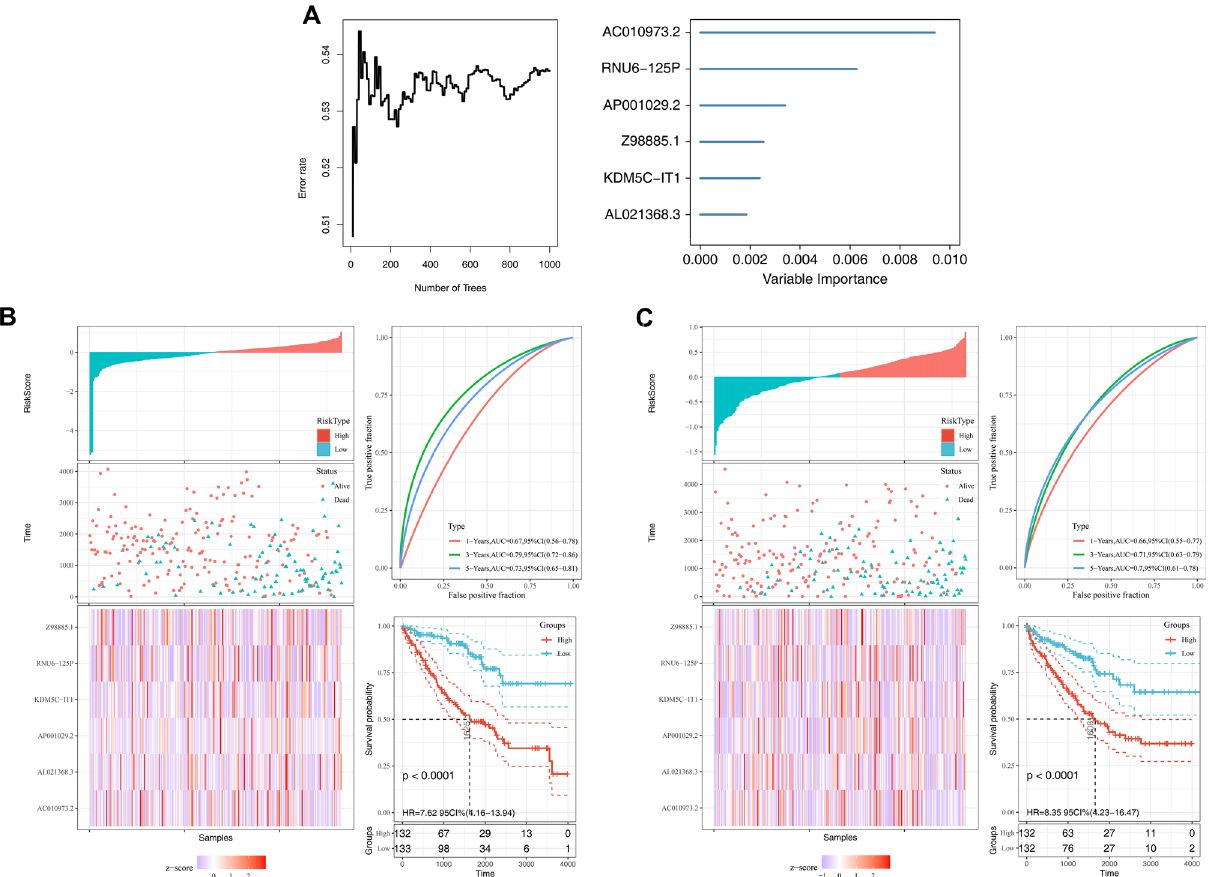
Figure 3. Establishment and assessment of the risk signature for ccRCC. Notes: ( A) Calculation of relative importance of each DEG in the prognosis of ccRCC patients using Random Forest algorithm. In ( B ) Training cohort and ( C ) Validation cohort, diagrams are risk score map (left top), survival status map (left medium), gene expression heat map (left bottom), time ‐ dependent ROC curves (right top) and Kaplan–Meier survival curves (right bottom). ROC: receiver operating (Fig. 3B) and validation (Fig. 3C) cohorts were equally divided into low ‐ risk and high ‐ risk groups. Diagrams of risk score (left top), survival status (left medium), the heat map of gene expression (left bottom), time ‐ depend- ent ROC curves (right-top), and Kaplan–Meier survival curves (right bottom) are shown in the figures. Time- dependent ROC curves showed AUC of the prognostic 6-gene signature of 0.67 at 1 year; 0.79 at 3 years and 0.73 at 5 years in the training cohort (Fig. 3B), and a similar outcome of 0.66 at 1 year, 0.71 at 3 years, and 0.7 at 5 years in the validation cohort (Fig. 3C). Survival analysis revealed a huge advantage OS of the patient in